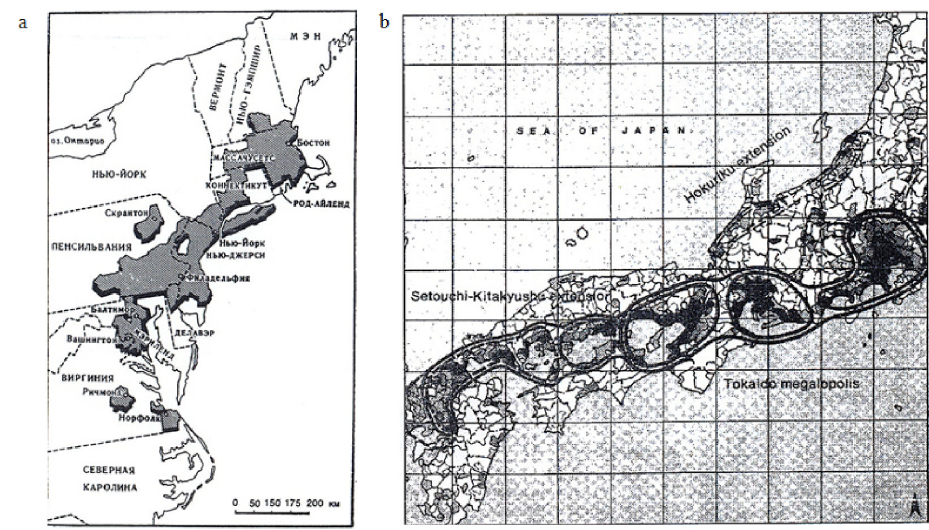
Figure 5. ( a ) Megalopolis “Boswash”, USA, according to J. Gottman [4,5]; ( b ) Megalopolis “Tokaido”, Japan, according to T. Doi